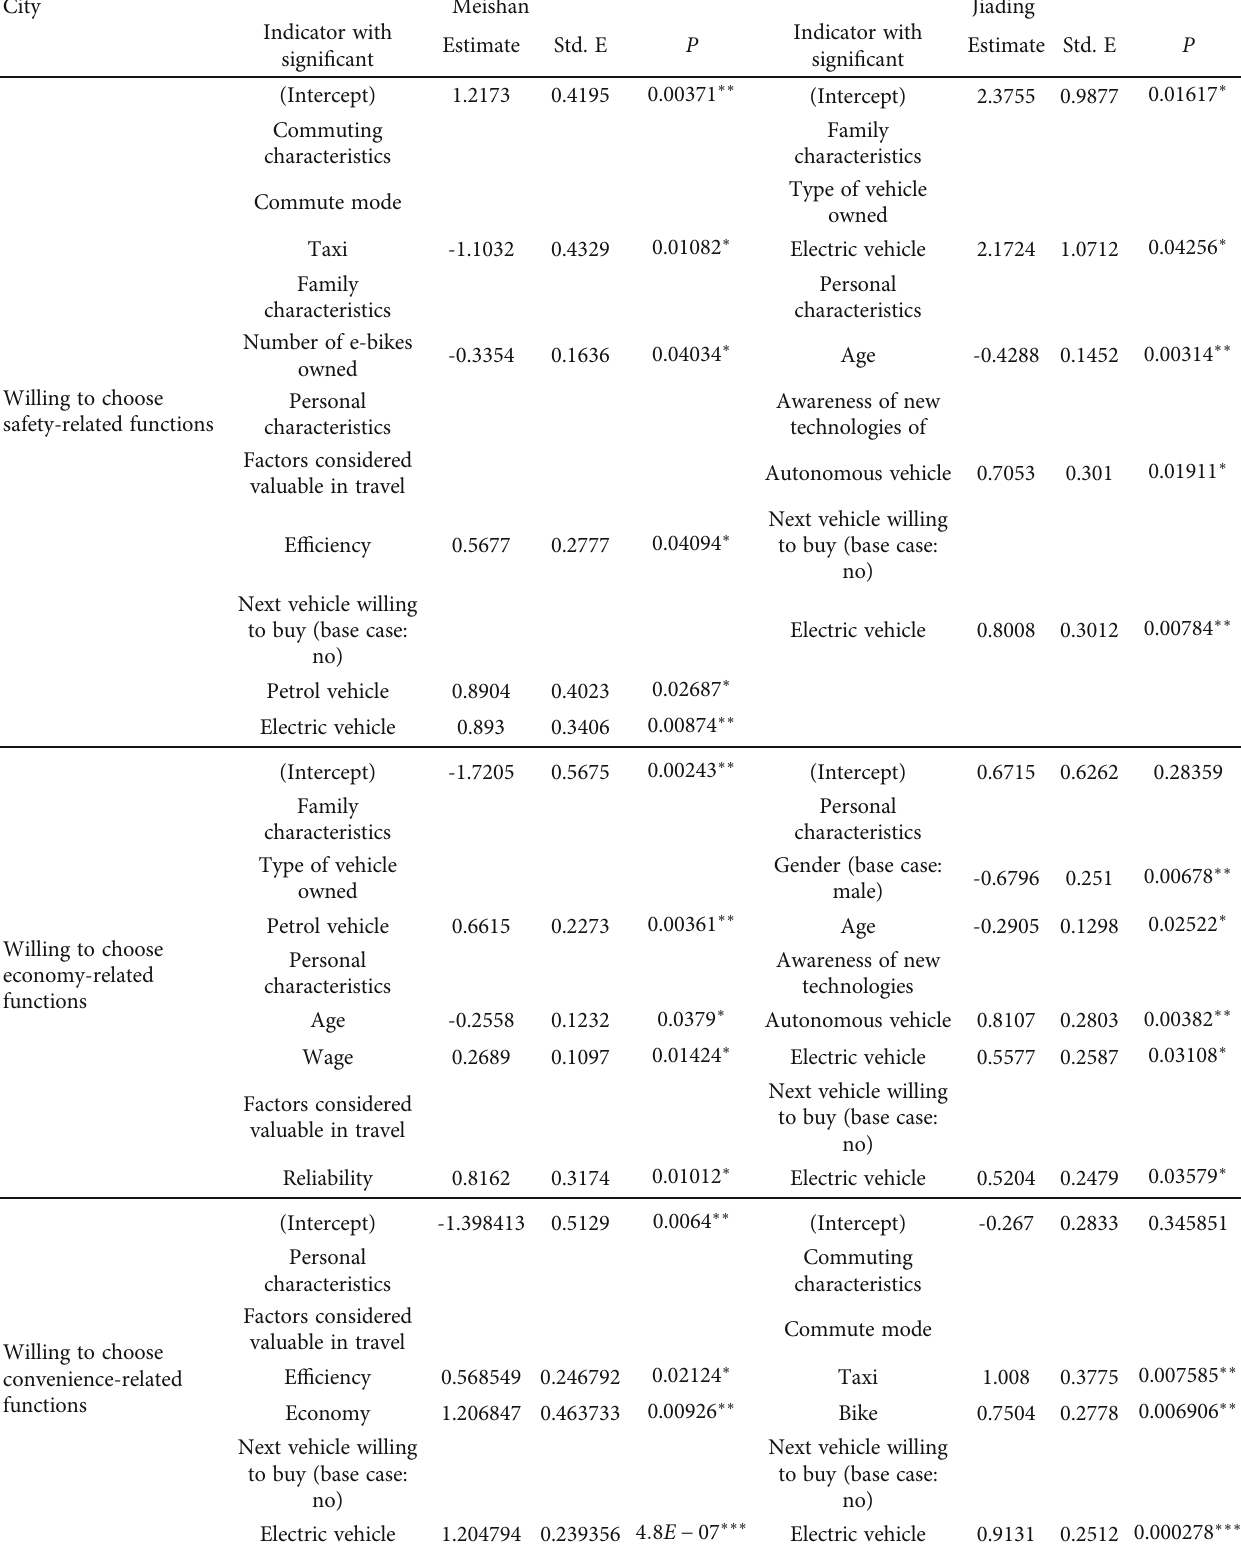
Table 7: Logit model for willingness to choose di ff erent ADAS or autonomous driving